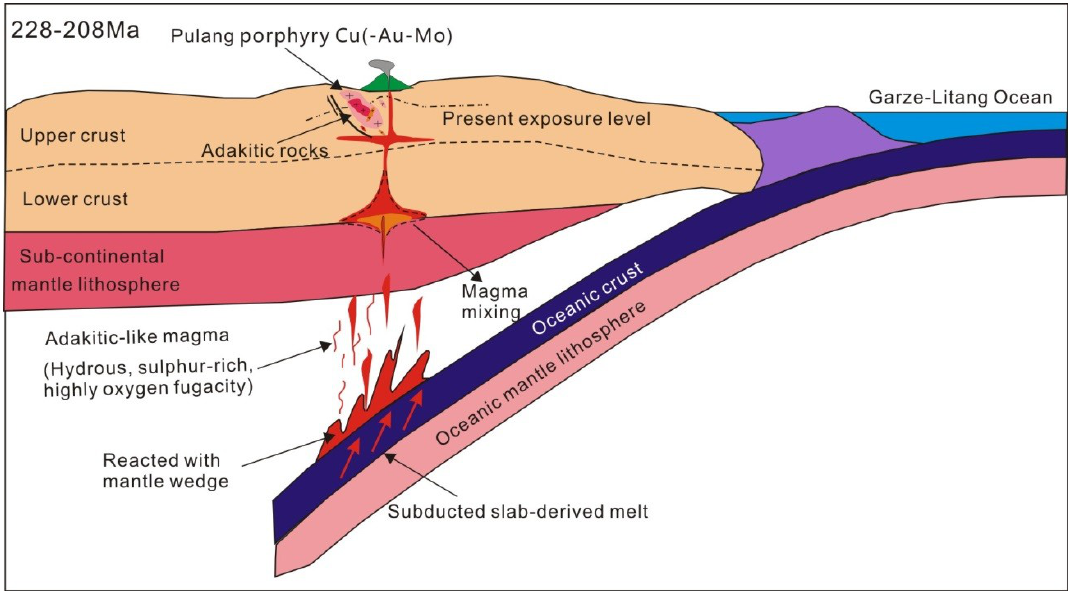
Table S1: LA-ICP-MS zircon U–Pb dating data of the porphyry intrusions in the Pulang Cu (–Mo–Au)